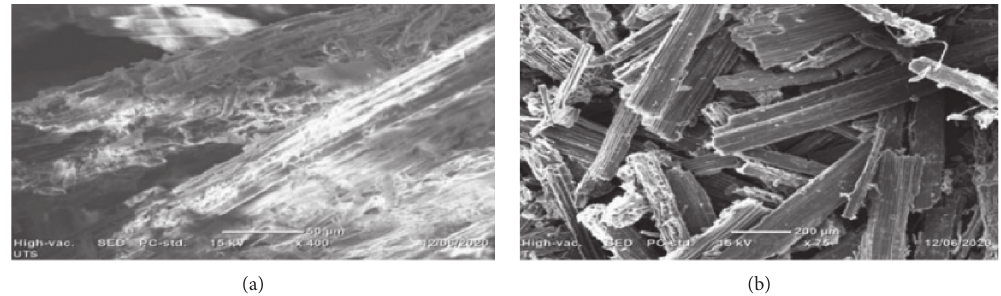
Figure 1: SEM analysis of raw (a) and acid hydrolyzed (b) Teff straw.